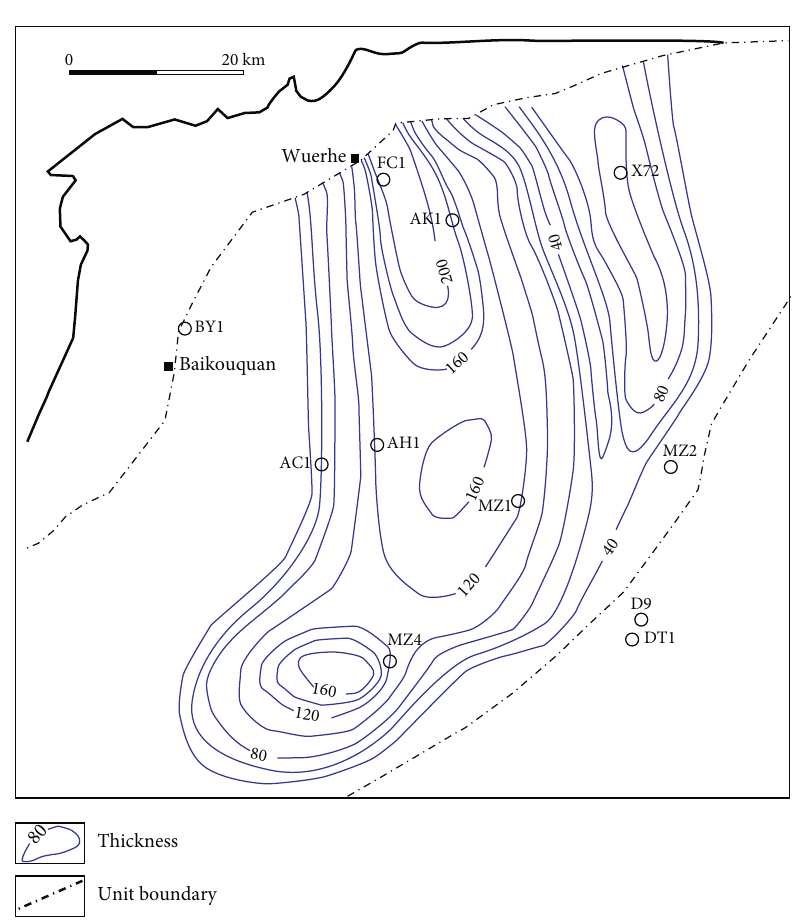
Figure 9: Contour map of the source rocks in the Fengcheng